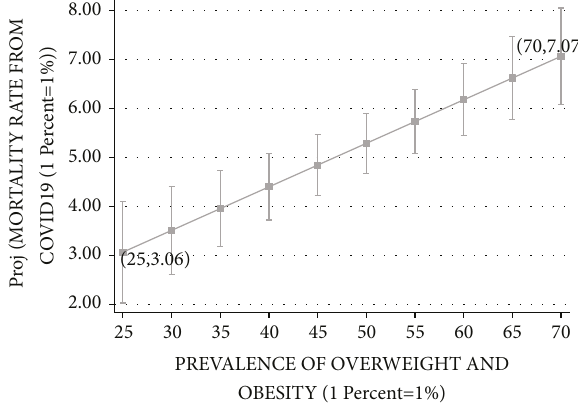
Figure 7: Mortality rate from COVID-19 vs. prevalence of overweight and obesity. The vertical axis measures the projected probability of mortality from COVID-19 based on the formula for each OECD country: 100n ( NUMBER OFDEATHSFROM COVID 19 ÷ TOTAL NUMBEROFCOVID19 PATIENTS ) . The horizontal axis measures the prevalence of overweight and obesity (BMI ≥ 25, where BMI � kg/meter 2 ) in the population of 23 OECD countries based on measured height and weight. The figure is based on the following regression outcomes given in column